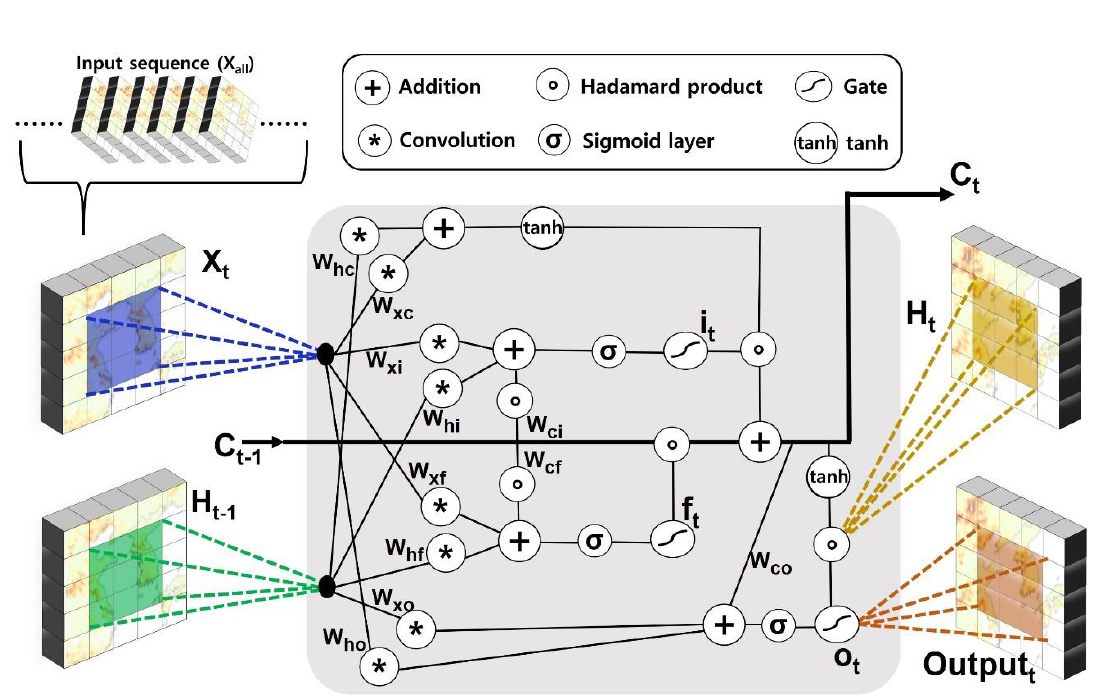
Figure 3. The structure of convolution long short term memory (ConvLSTM) model used in this research. Three layers used in the ConvLSTM model have the same structure shown in a gray shading box. X , H, C, i, f, and o are input sequence, hidden state, memory cell, input gate, forget gate, and output gate, respectively.